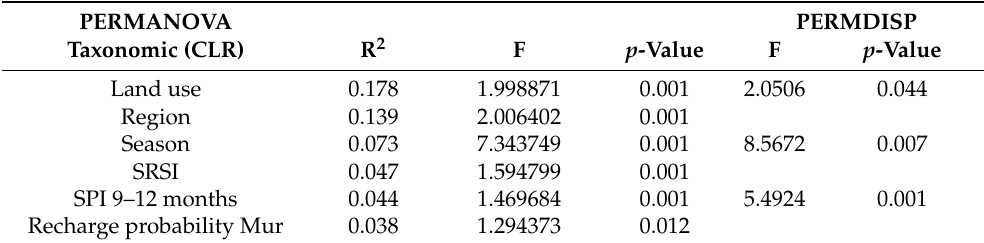
Table 4. PERMANOVA and PERMDISP analysis of the effect of sampling region, season, land use, correlation of groundwater levels with precipitation, and Mur River water levels on beta diversity of prokaryotic communities measured by clr (999 permutations) (SRSI: Standardized River Stages Index, SPI: Standardized Precipitation Index).